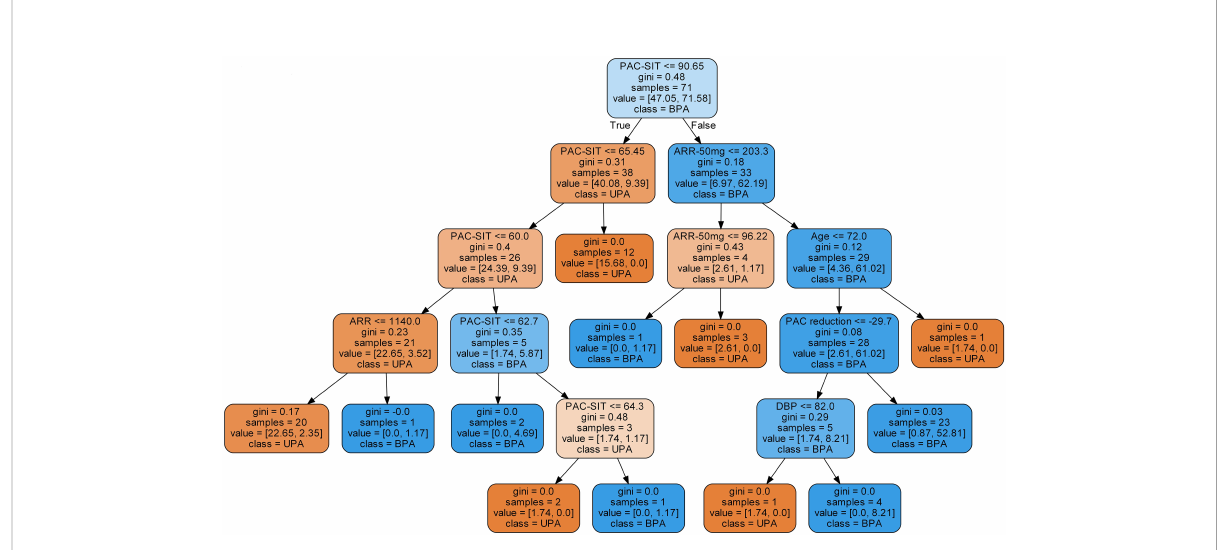
FIGURE 2 One of the prediction trees in the model using Random Forest classi fi er.